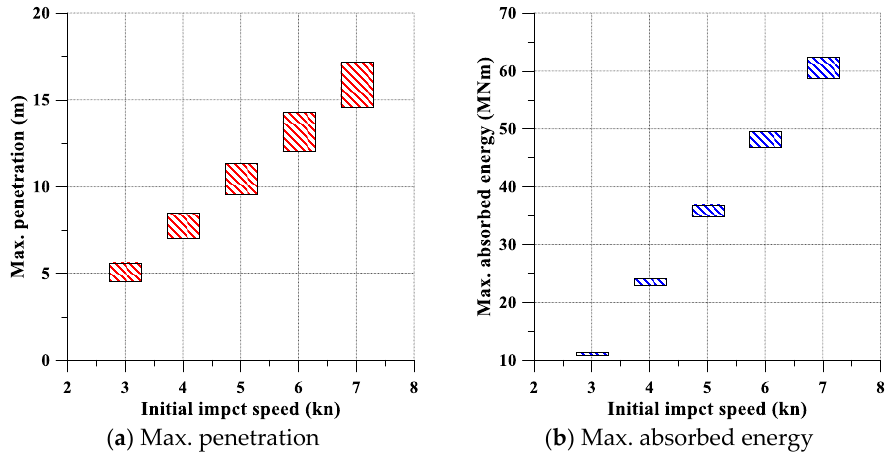
Figure 12. Upper and lower bounds of maximum damage obtained by the formula.